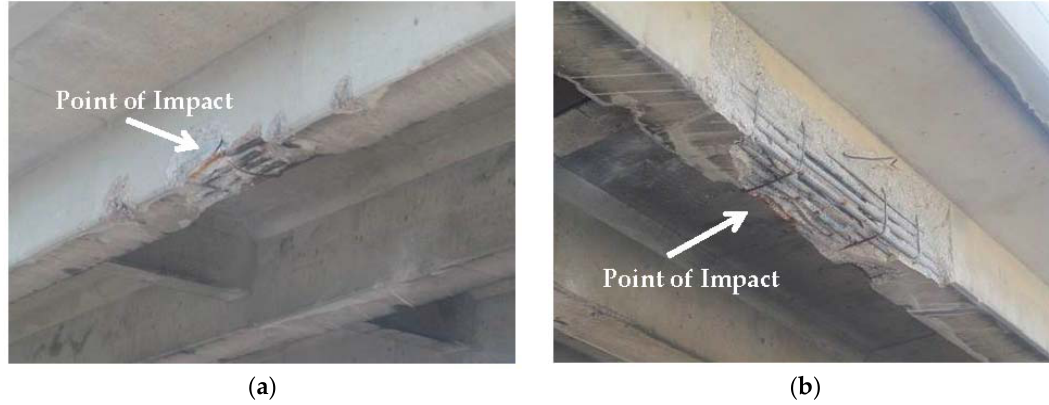
Figure 3. Impact damaged reinforced concrete (RC) girders ( a ) Impact side of Girder G1; ( b ) Back side of Girder G4.